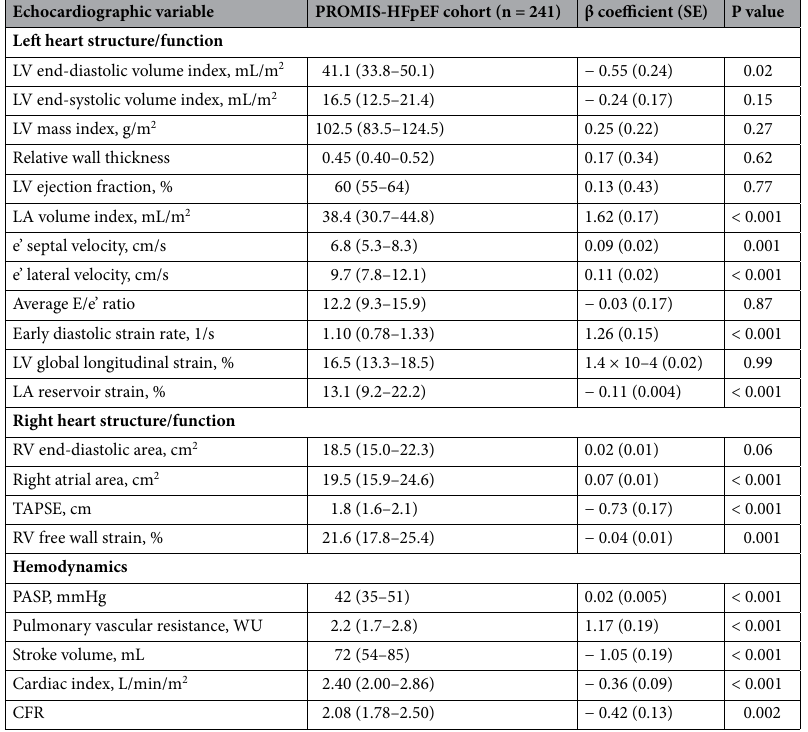
Table 2. Echocardiographic variables associated with disproportionate left atrial myopathy. Continuous variables are reported as median (interquartile range). CFR coronary flow reserve, LA left atrial, LV left ventricular, PASP pulmonary artery systolic pressure, RV right ventricular, TAPSE tricuspid annular plane systolic excursion.